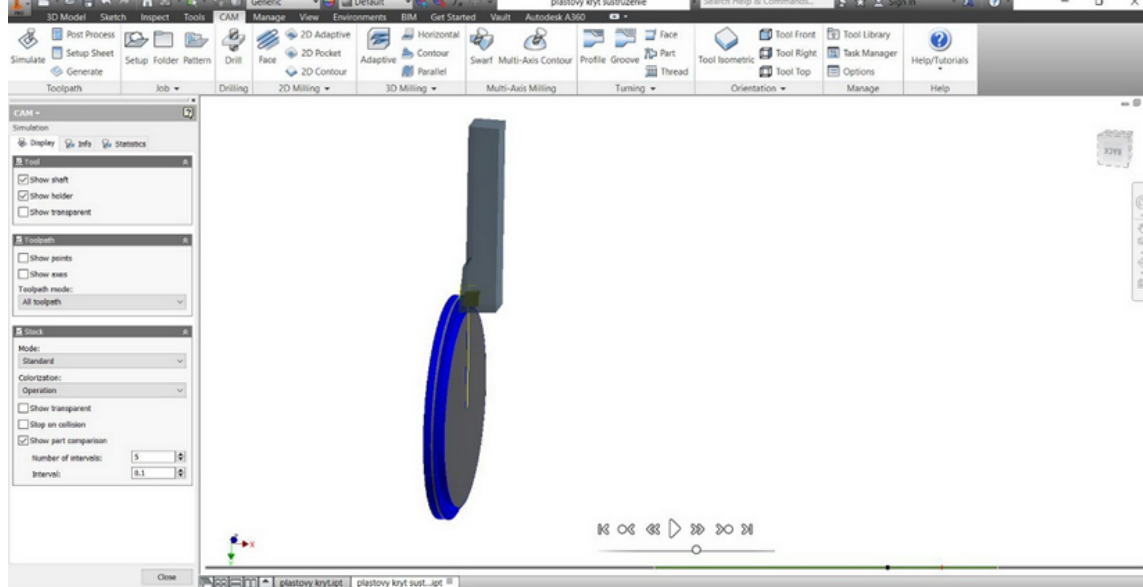
Figure 7: Simulation production of 126 mm diameter to 6 mm depth.